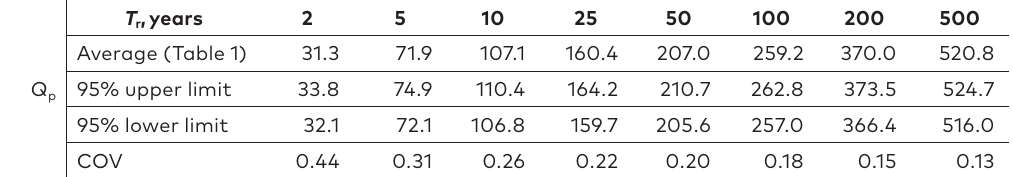
Table 2. Computed peak discharges from average and generated values, confidence intervals and COV values of peak discharges